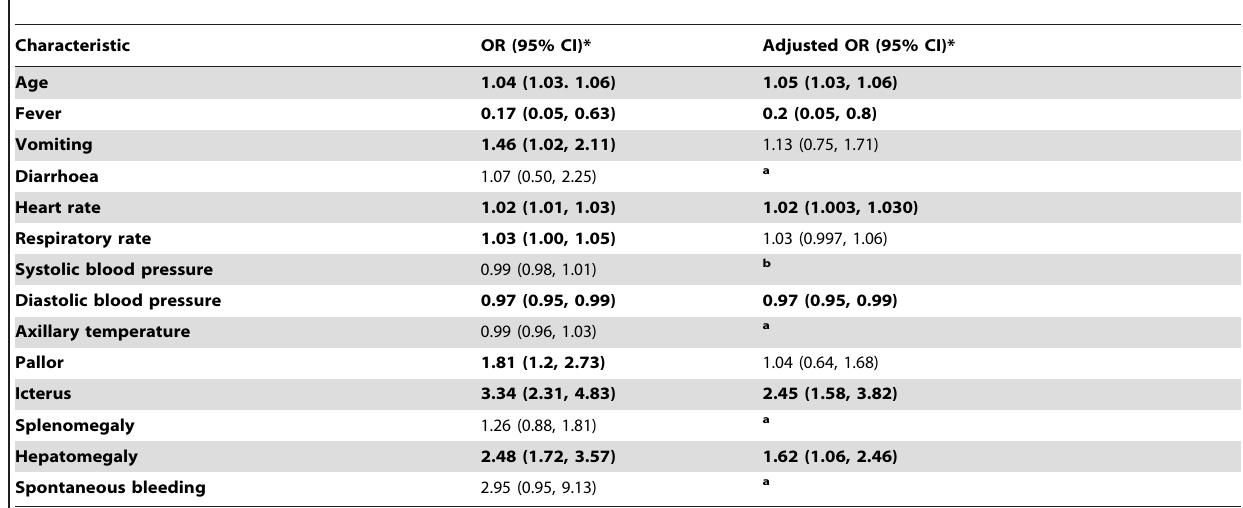
Table 5. Univariate and Multivariate Analysis for History and Physical Examination Factors Associated with AKI.